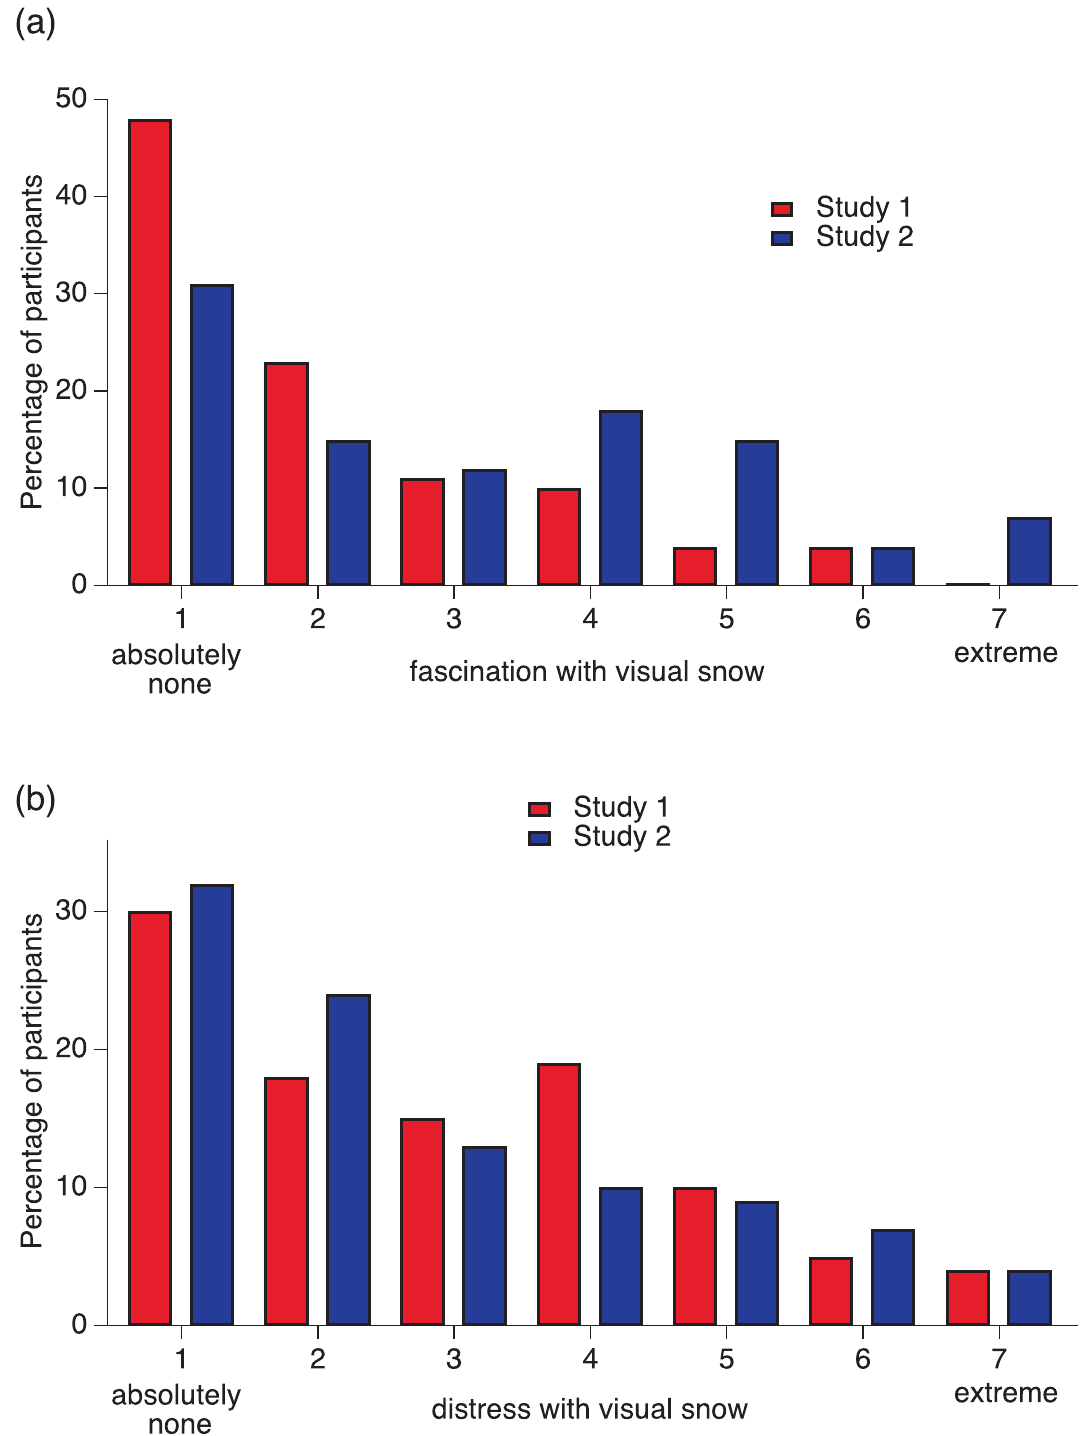
Fig 3. Distress and fascination with visual snow. (a) Percentage of participants with different degrees of distress with visual snow. (b) Percentage of participants with different degrees of fascination with visual snow. Red bars: Data from Study 1. Blue bars: Data from Study 2.